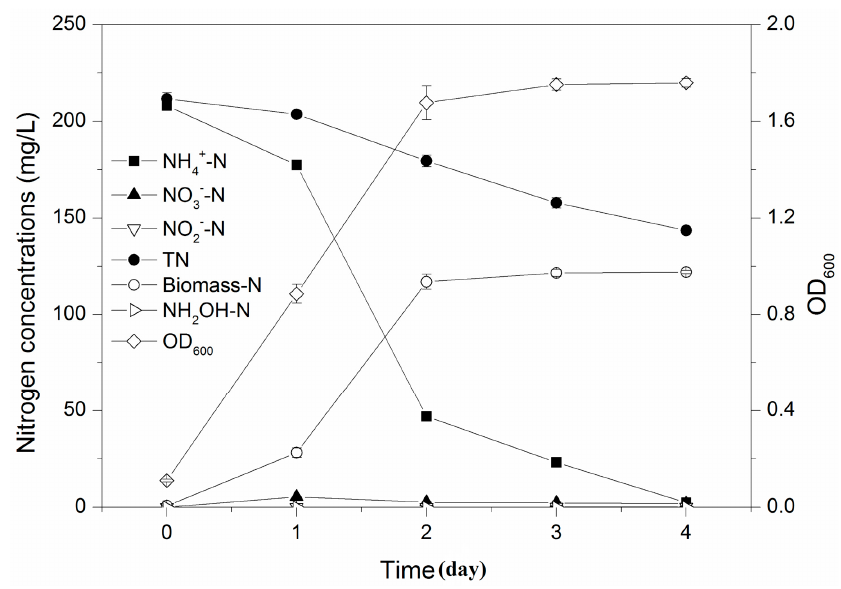
Figure 1. Heterotrophic nitrification characteristics of strain Y-12 in the presence of NH 4 +